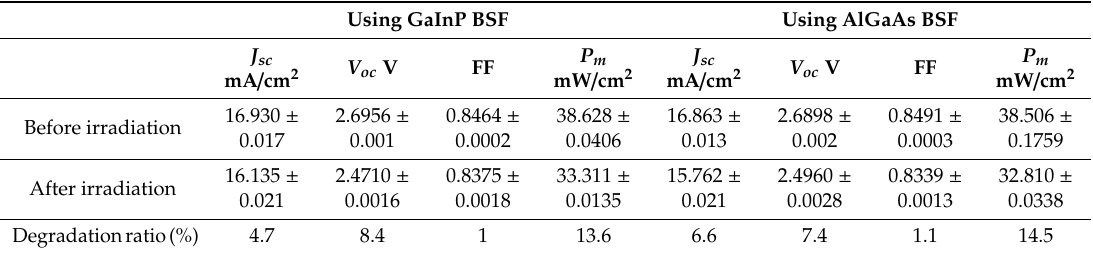
Table 1. Comparison of the I-V characteristics of the two types of solar cells before and after electron beam irradiation. Using GaInP BSF Using AlGaAs BSF